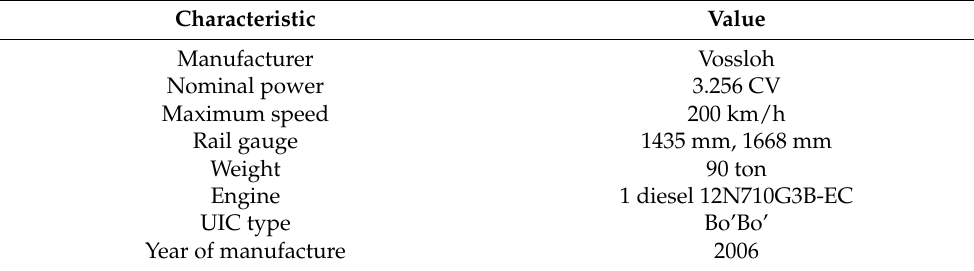
Figure 6. Tractive effort vs. speed profile. Table 2. Vossloh S-334 diesel–electric locomotive